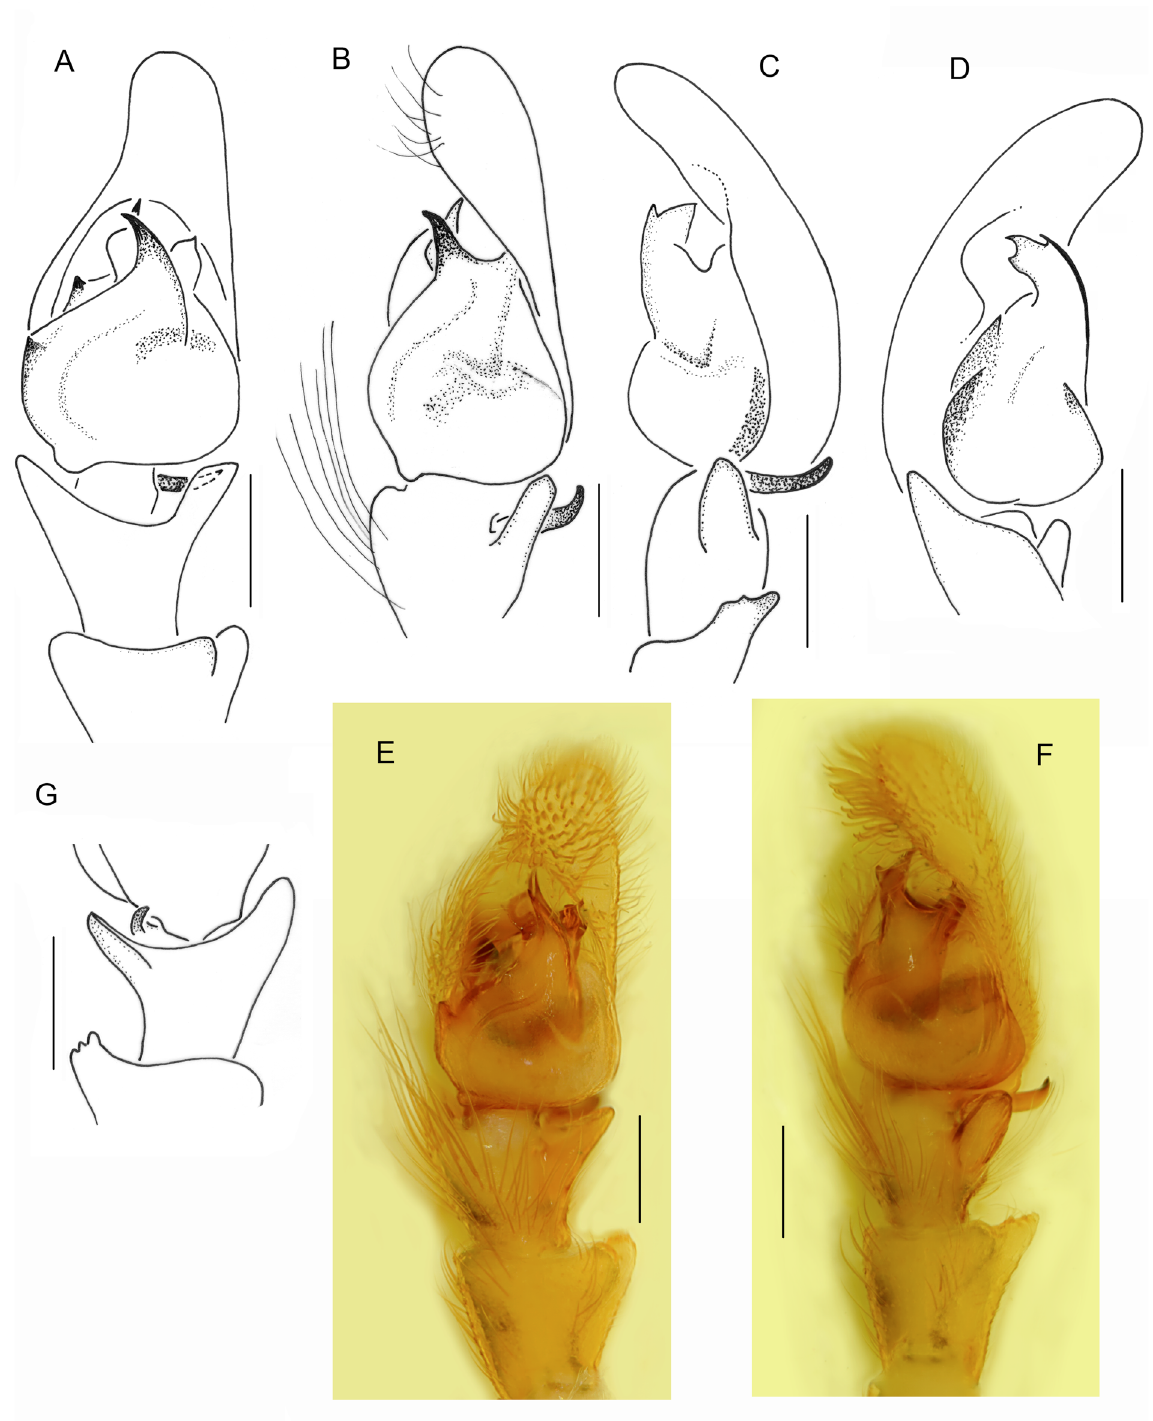
Fig. 7. Pochytoides patellaris sp. nov., holotype, ♂. A–F . Palpal organ. A , E . Ventral view. B , F . Ventroretrolateral view. C . Retrolateral view. D . Ventroprolateral view. G . Palpal apophyses, dorsal view. scale bars: 0.3